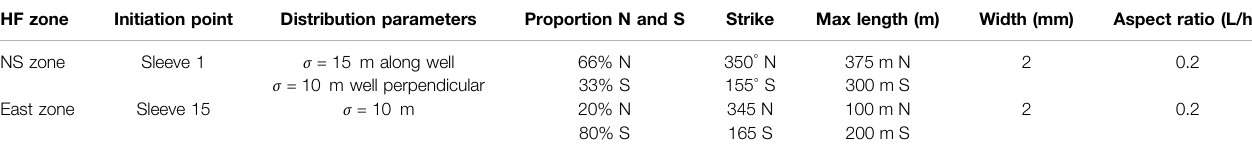
TABLE 1 | Summary of the parameters used to characterize the model hydraulic fractures. HF zone